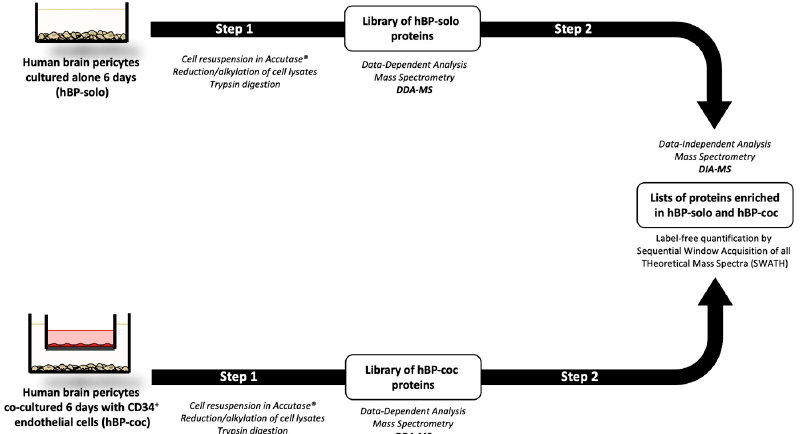
Figure 1. Graphical experimental design of the study. Human brain pericytes (hBP) are processed for mass spectrometry analysis after 6 days alone (hBP-solo) or in coculture with CD34 + endothelial cells (hBP-coc). 6 days correspond to the time necessary to promote the BBB main features on in the coculture model used, and therefore to optimize bidirectional cell-cell communications along the BBB establishment. Step 1 refers to the setup of protein libraries in both conditions (DDA-MS), Step 2 corresponds to the generation of label-free SWATH quantification of proteins enriched in hBP-solo or in hBP-coc conditions (DIA-MS